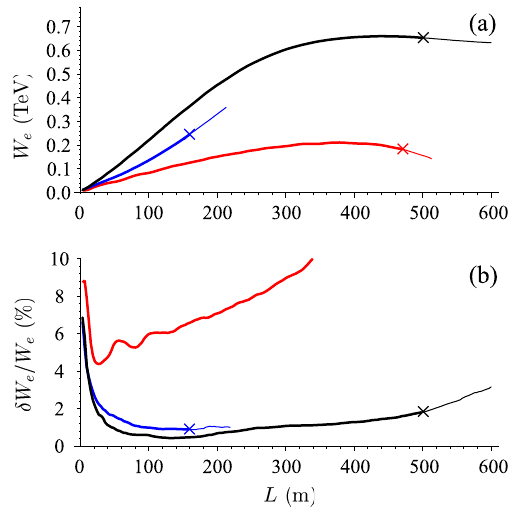
FIG. 10. (Color) Witness energy (a) and energy spread (b) versus traveled distance for optimum (black), low (blue), and high (red) driver emittances. The crosses mark points of witness depopulation.